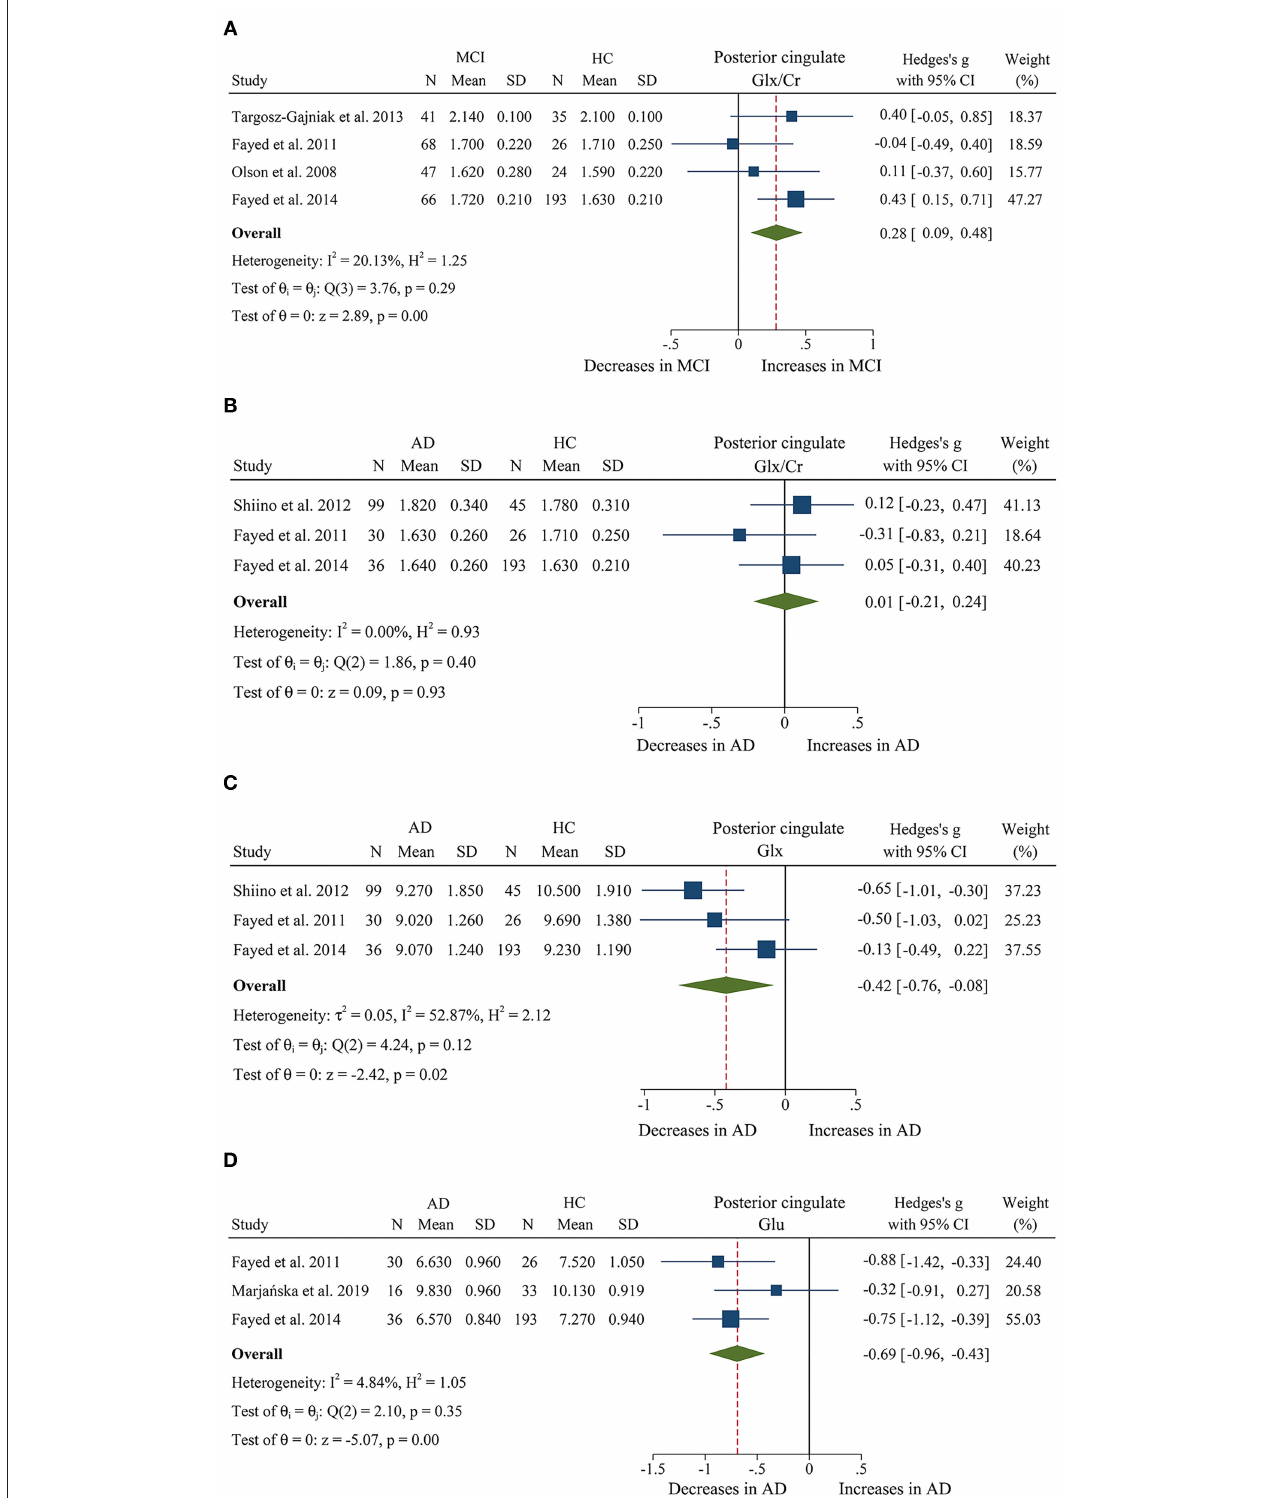
FIGURE 6 | Forest plots show the change of the levels of Glx/Cr, Glx, and Glu in the posterior cingulate between MCI, AD patients, and HC subjects. (A) Data include 500 individuals from 4 studies for meta-analysis of Glx/Cr levels between MCI and HC. (B) Data include 429 individuals from 3 studies for meta-analysis of Glx/Cr levels between AD and HC. (C) Data include 429 individuals from 3 studies for meta-analysis of Glx levels between AD and HC. (D) Data include 334 individuals from 3 studies for meta-analysis of Glu levels between AD and HC.